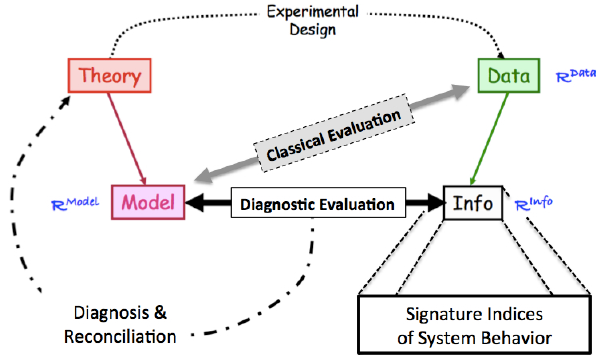
Fig. 4. Classical versus Diagnostic model evaluation. The classical approach compares model simulations directly with the collected data. In the diagnostic approach, patterns in the model simulations are compared with corresponding patterns in the data (figure based on ideas from Gupta et al.,